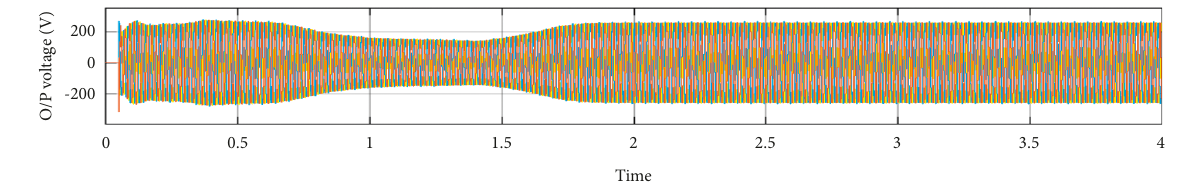
Figure 12: PV array output with traditional P and O